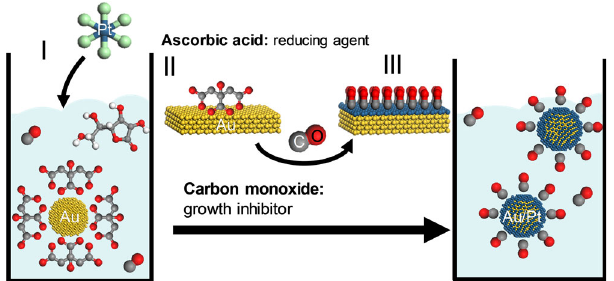
Fig. 1 Conceptual pathway of the chemically induced self-limiting growth of Pt on Au nanoparticles. To a CO-saturated solution of citrate capped gold nanoparticles and ascorbic acid, H 2 PtCl 6 is added (I). Ascorbic acid is oxidized on the Au-surface while Pt is reduced (II). After Pt-deposition, CO acts as growth inhibitor resulting in core-shell nanoparticles